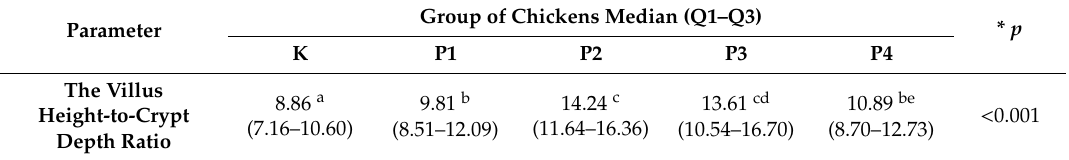
Table 4. The villus height-to-crypt depth ratio of broiler chickens on the 42nd day of the feeding trial.